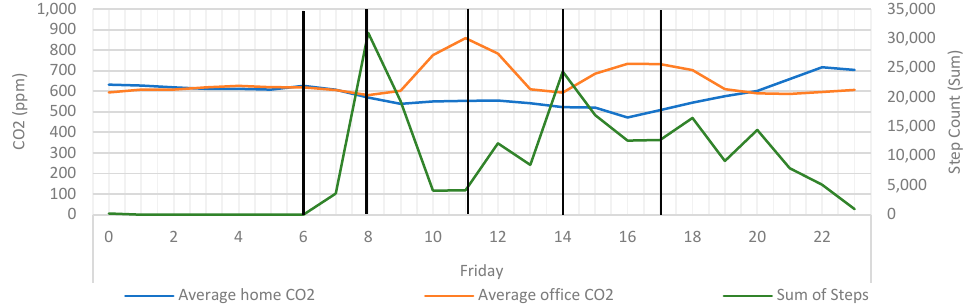
Figure 11. Average home/office CO 2 overlayed with sum of steps and key event markers. Vertical black lines signify the point when CO 2 rises or falls.